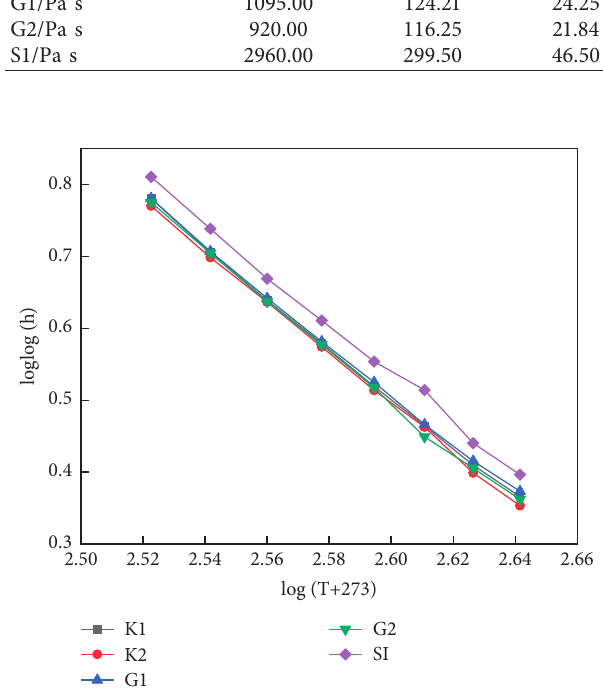
Figure 1: Viscosity-temperature curve.